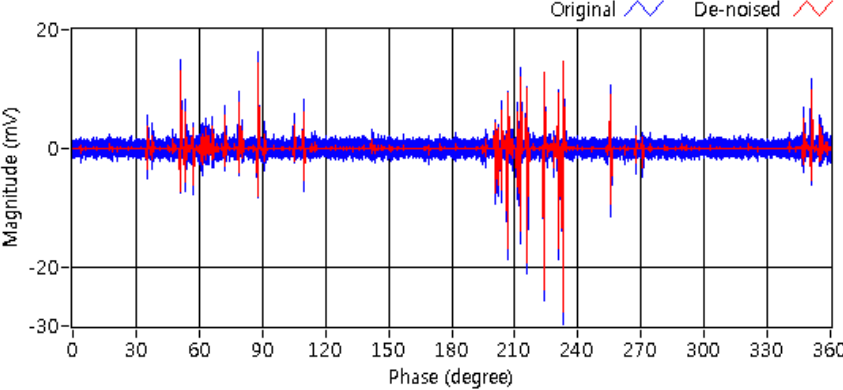
Figure 8. De-noising of detail component D1.